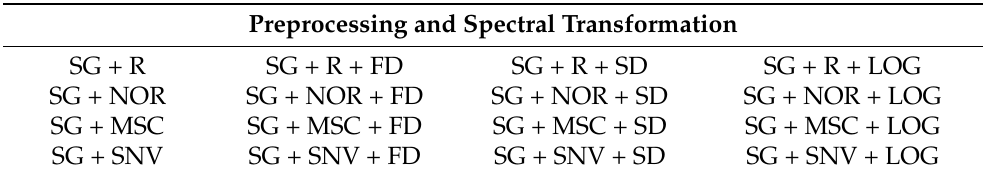
Table 1. Combination method of spectral data preprocessing and spectral